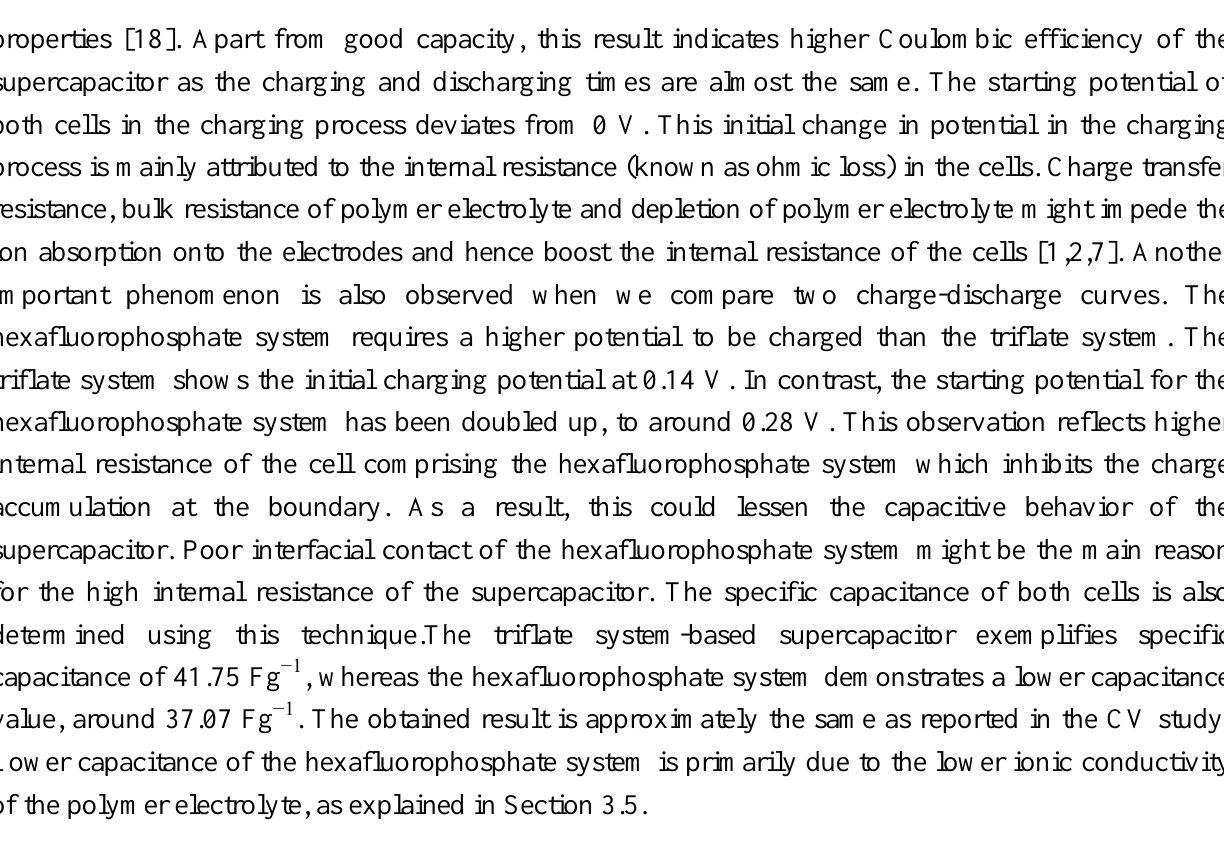
Figure 7. Galvanostatic charge-discharge performances of different ionic liquid-based biopolymer electrolyte